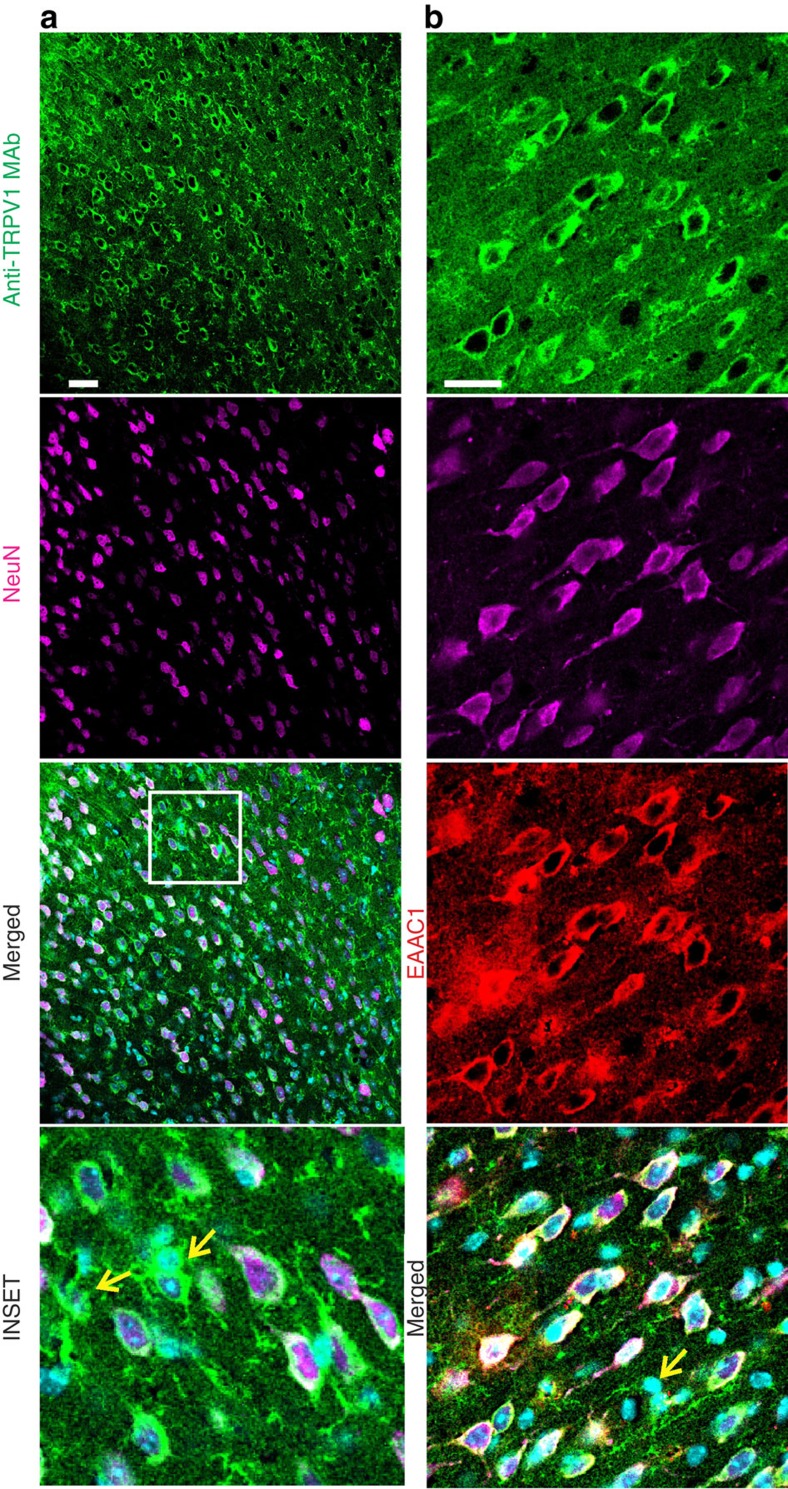
TRPV1 is also expressed in principal neurons of the ACC from CCI adult mice.Contralateral ACC photomicrographs of 4 weeks CCI mice, from two independent experiments (a,b). (a) Anti-TRPV1 MAb labels both the cytoplasm and the apical dendrite of NeuN positive cells. The remnant TRPV1 positive fibers and cytoplasms probably belong to glial cells (yellow arrows). (b) Anti-TRPV1 MAb labels EAAC1 positive neurons and NeuN negative cells (yellow arrow).